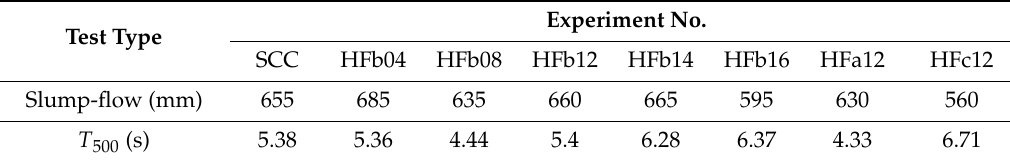
Table 8. Test results for fresh self-compacting SFRC.